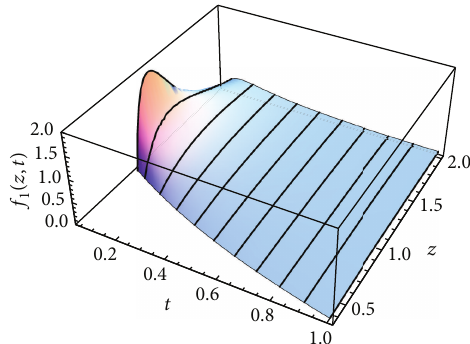
Figure 9: Plot of 𝑓 1 (𝑧, 𝑡) given by (95) in Example 18 at different values of 𝑡 = {0.05, 0.1, 0.2, 0.3, . .. ,1} in the case that 𝐵 ∼ Ga (2;4) , 𝑡 0 = 0 , 𝑧 0 = 1 , and 𝑎 = −1